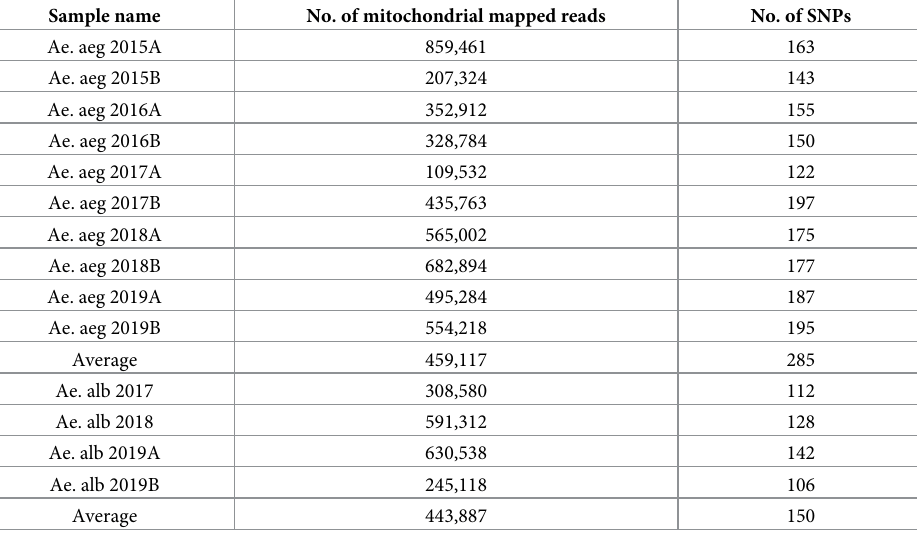
Table 2. Results of mitochondrial diversity analysis showing the numbers of mitochondrial mapped reads and